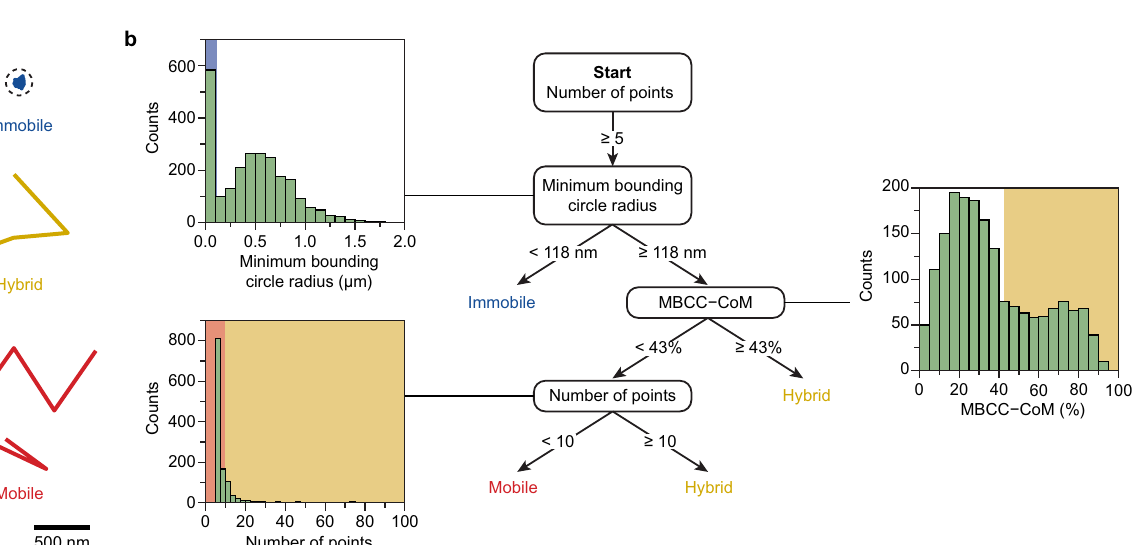
Figure 2. ( a ) Example trajectories of the immobile, hybrid, and mobile population. The dashed circle has a radius of the minimum bounding circle radius and marks the immobile segments in the trajectories. ( b ) Classification tree obtained with machine learning on a training set of 100 manually classified trajectories for a simulated dataset with transient trapping. The classification tree is read from top to bottom for each trajectory, weighing one property at each branch, until the trajectory is classified as either mobile, immobile, or hybrid. At each split, the histogram of the property is given for all trajectories of the branch, with the background colour indicating the threshold value of the